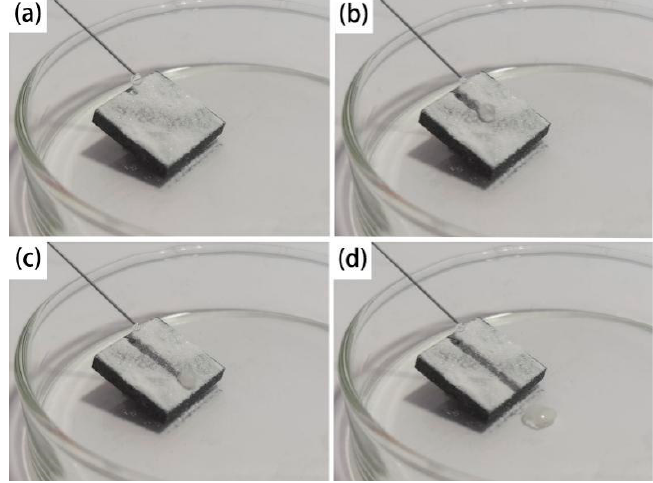
Figure 9. Self-cleaning performance of the SMA surface. ( a ) Dripping; ( b ) Water drop contact; ( c ) Water drop rolling; ( d ) Water droplets roll